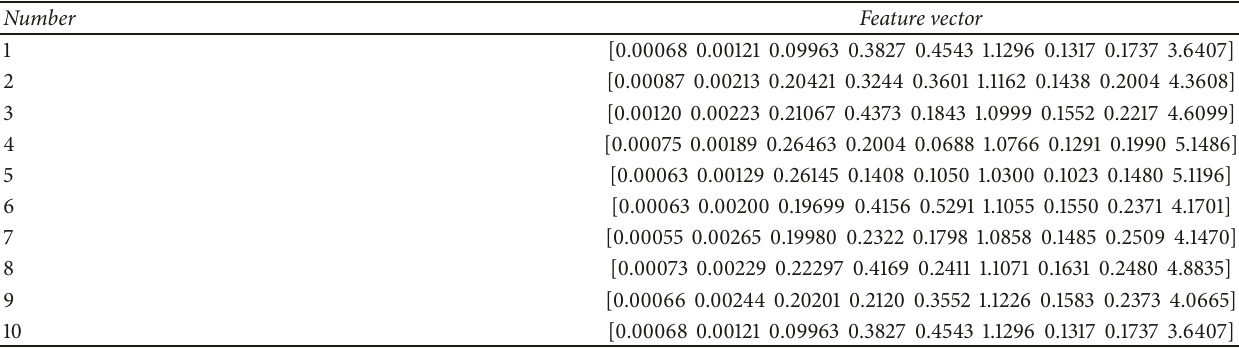
Table 4: The feature vector of corn’s multiwavelet entropy of the severe drought stress group.